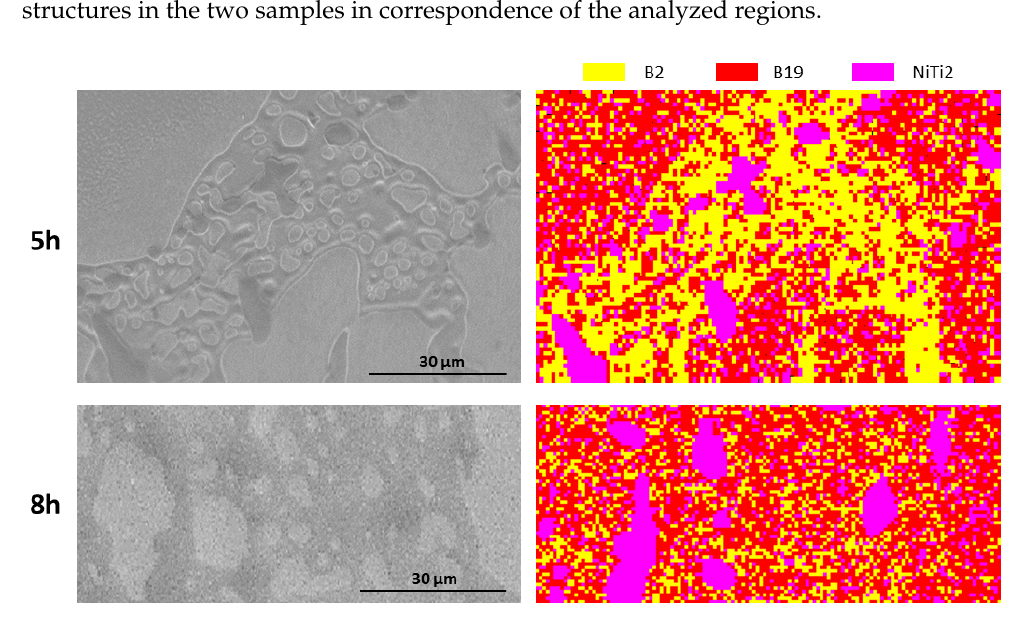
Figure 8. SEM micrographs of 850C5h and 850C8h samples and the related B2, B19, and NiTi2 crys- tal structures distribution identified by EBSD. structures distribution identified by